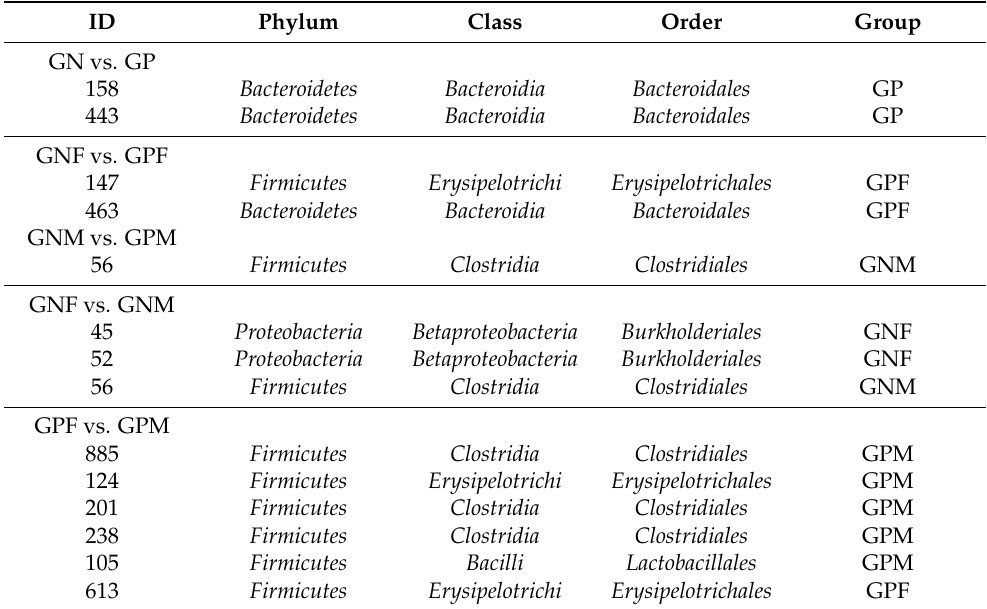
Table 2. Differential abundance of microbial taxa among groups. In the “Group” column are reported the groups with higher abundance. GP = Giardia -positive; GN = Giardia -Negative; GPF = Giardia -Positive Females; GPM = Giardia -Postive Males; GNF = Giardia -Negative Females; GNM = Giardia -Negative Males. ID Phylum Class Order Group GN vs. GP 158 Bacteroidetes Bacteroidia Bacteroidales GP 443 Bacteroidetes Bacteroidia Bacteroidales GP GNF vs.